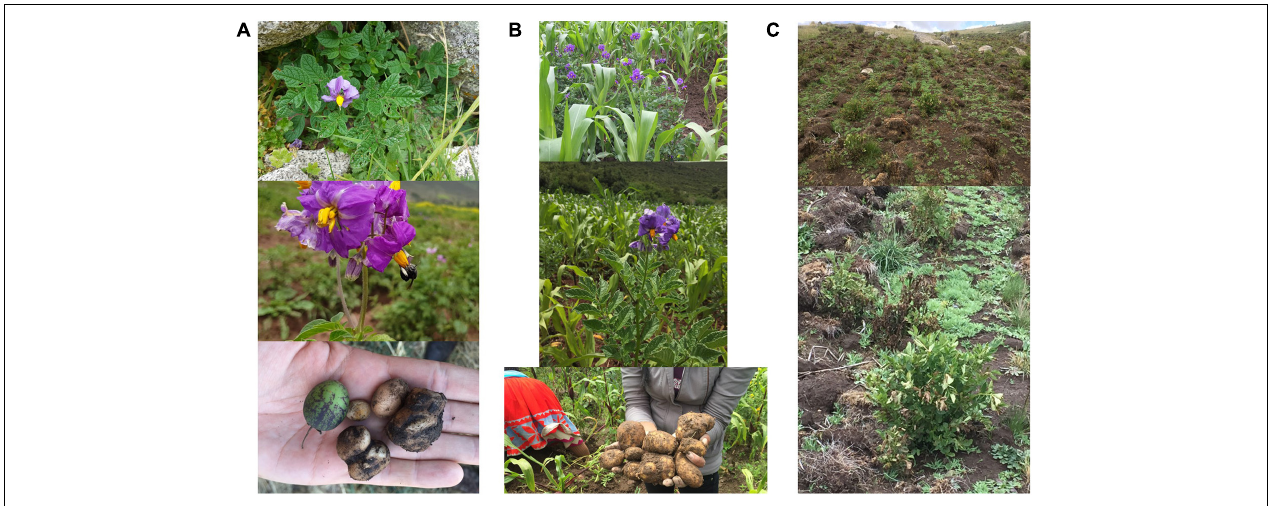
FIGURE 1 | Wild, weedy, and cultivated potatoes of the Andean region of southern Peru. (A) Solanum candolleanum , the atoq papa or sacha papa used in this study for experimental crosses with cultivated potatoes; the photograph shows from top to down the general aspect of the plant in a rocky environment, details of flowers, fruits and the small tubers; (B) araq papas , from top to down it is possible to see the aspect of the weedy plants associated to maize, and the size of tubers compared with the atoq papa ; (C) k’ipa papas , the photos show aspects of some plants in fallow agricultural fields cultivated with potatoes the year before; plants emerged may derive from non-harvested tubers, as well as recruitment of plants from